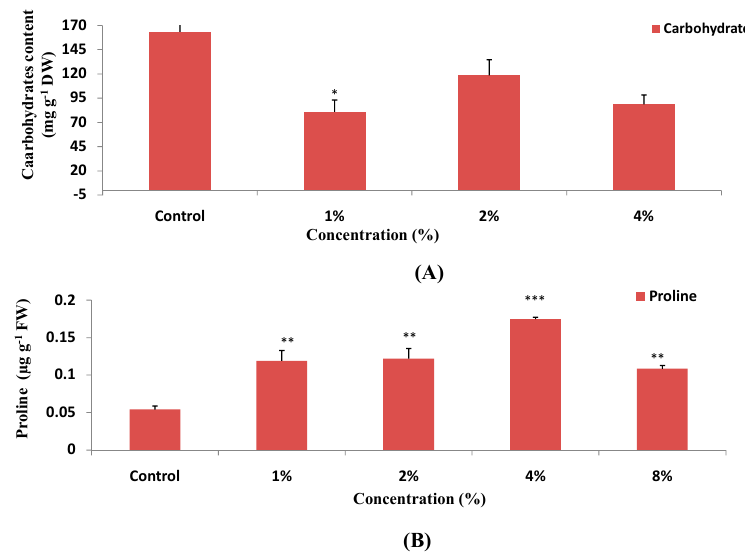
Figure 6. Effect of the aqueous extract of H. persicum on carbohydrates and proline contents in wheat. Carbohydrates ( A ) and proline ( B ). * = significant, ** = highly significant and *** = very highly significant. Crl = Control.